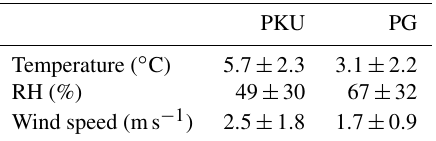
Table 2. Meteorological parameters at PKU and PG during the cam-